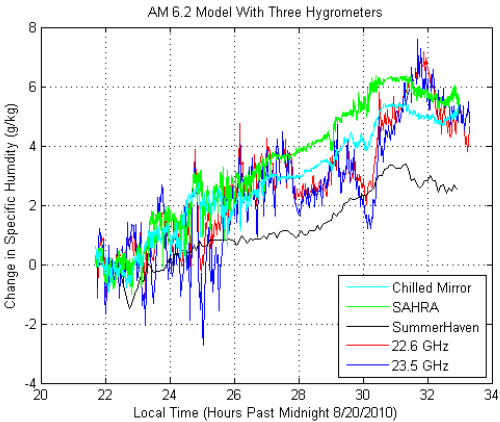
Fig. 11. Five curves each representing a particular measured change in specific humidity. The ATOMMS 22.6GHz and 23.5GHz chan- nel amplitudes have been converted to specific humidity using the AM 6.2 spectroscopic